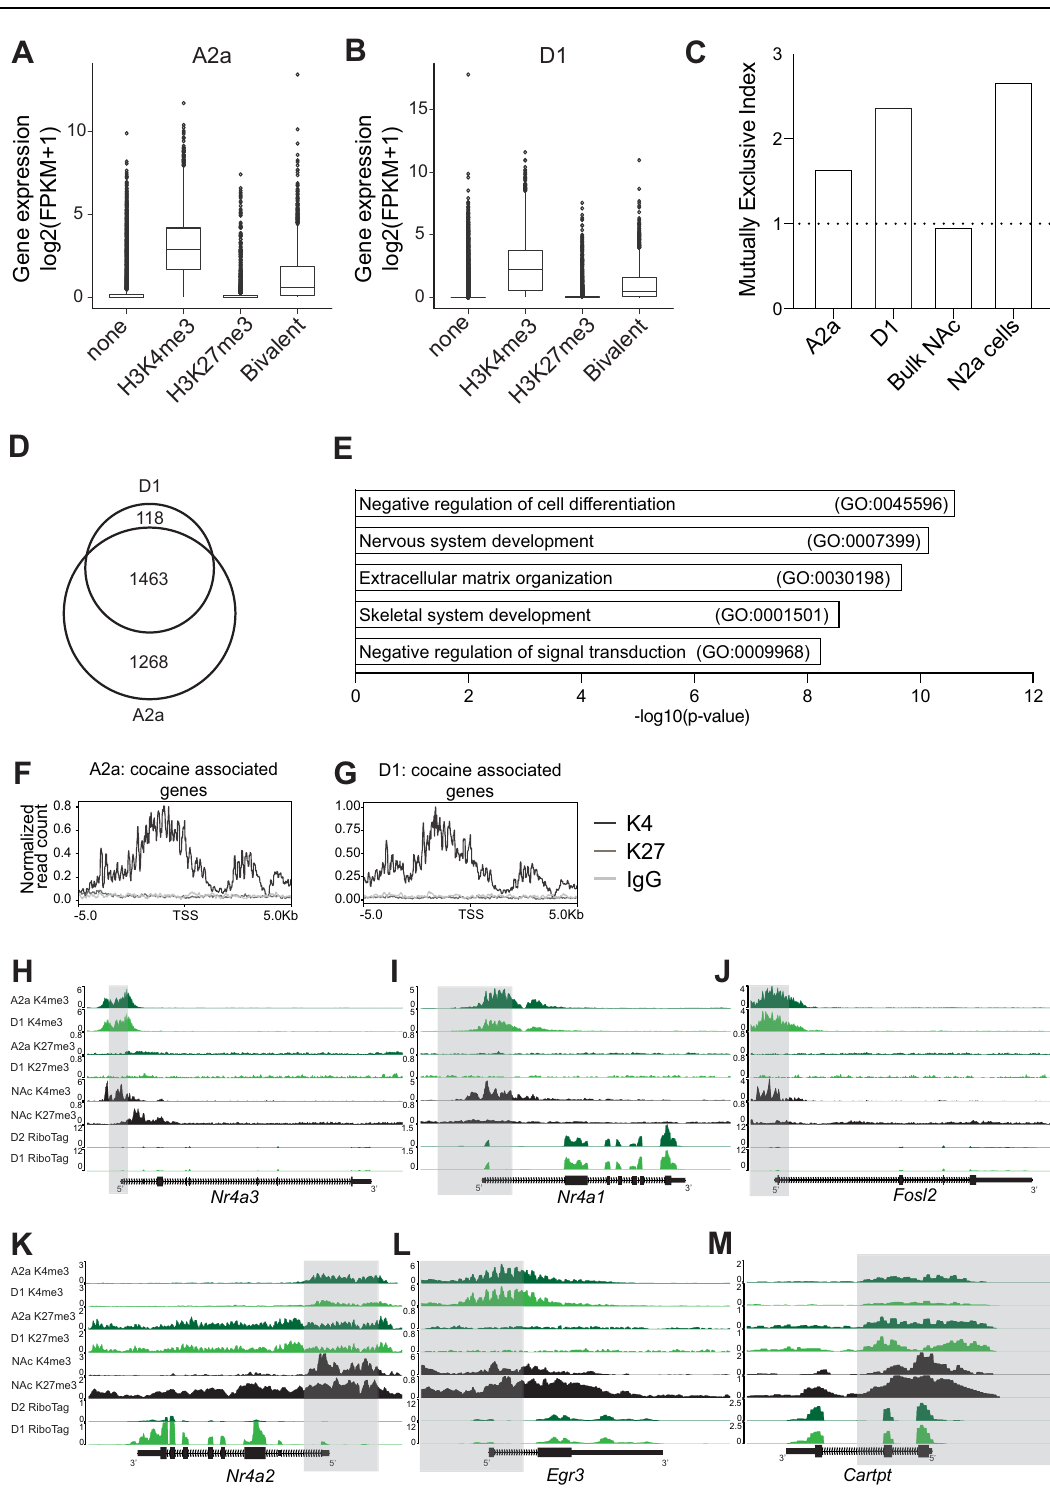
FACS to isolate MSNs, but we found that the af fi nity puri fi